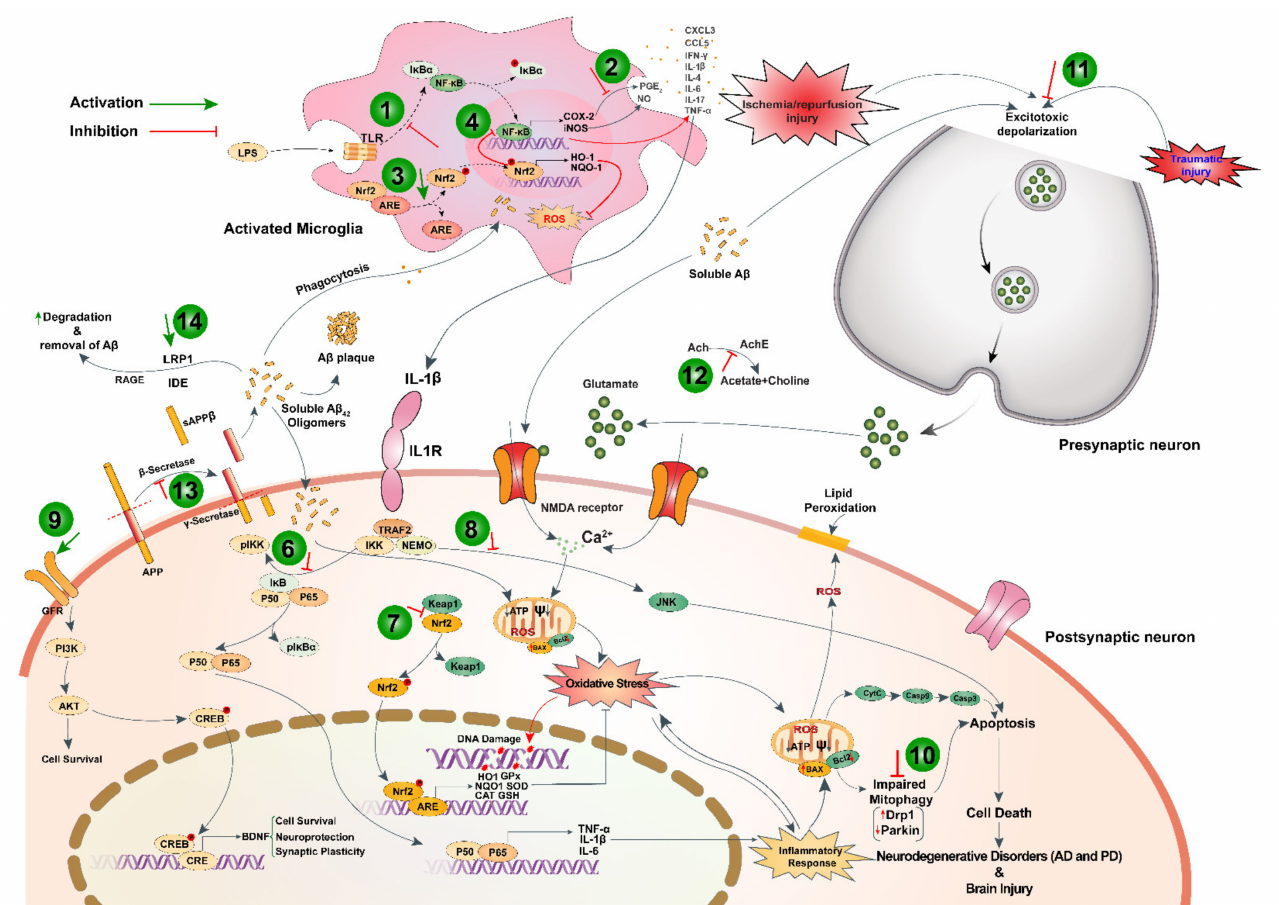
Figure 3. A schematic diagram illustrating the pathobiology of degenerative brain disorders and post-ischemic/traumatic consequences showing point of action of black cumin and TQ. The neuroprotective mechanisms of black cumin and TQ involve (1) attenuation of inflammatory response via inhibition of NF- κ B signaling; (2) inhibition of COX-2 activity; (3) induction of antioxidant defense system via activation of Nrf2/ARE pathway; (4) cross-talk between Nrf2 and NF- κ B; and (5) attenuation of oxidative stress in activated microglia; (6) protection against neuroinflammation by inhibiting NF- κ B signaling; (7) priming of antioxidant defense system by activating Nrf2/ARE pathway; (8) prevention of apoptosis via downregulating pro-apoptotic JNK/Erk pathway; (9) activation of BDNF-dependent pro-survival pathway via inducing PI3K/Akt signaling; and (10) induction of mitophagy in neuron; (11) attenuation of I/R-injury via preventing excitotoxic depolarization in presynaptic terminal of neuron; (12) anticholinesterase activity; (13) anti-amyloidogenesis via blocking β -secretase activity; and (14) A β -clearance by upregulating IDE, LRP1, and RAGE. TLR, toll-like receptor; LPS, lipopolysac- charide; NF- κ B (p50-p65), nuclear factor kappa-light-chain-enhancer of activated B cells; Nrf2, nuclear factor erythroid 2-related factor 2; ARE, antioxidant response element; IkB, inhibitor of NF- κ B; IKK, I κ B kinase; Keap1, Kelch-like